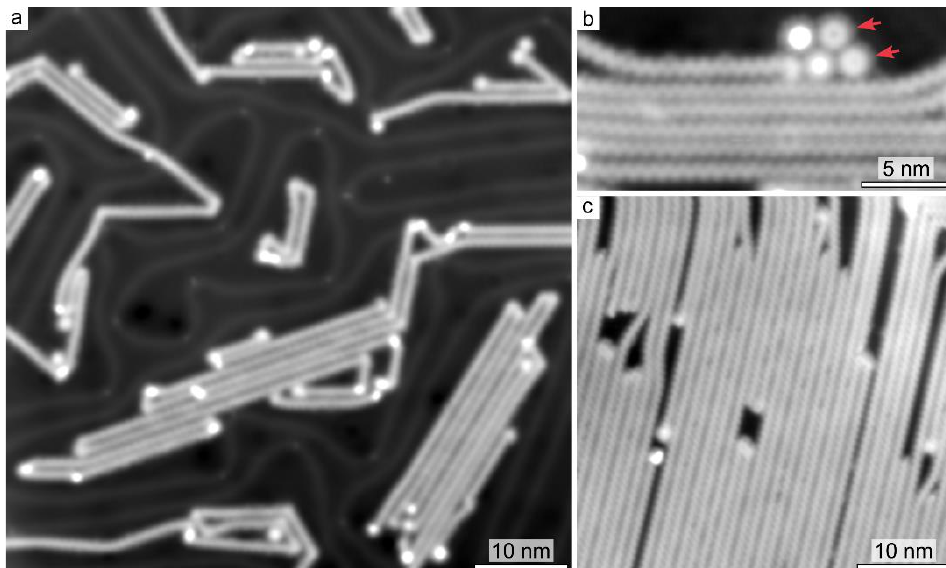
Figure 1. Constant-current STM images after annealing to 470 K of a Au(111) surface covered by a submonolayer ( a , b ) and multilayer ( c ) of DBTP. ( b ) Arrows highlight macrocycles. Measurement parameters: ( a ) tunneling current I = 1.9 pA, sample bias voltage V = 1.0 V; ( b ) I = 5 pA, V =1.0 V; ( c ) I = 2.6 pA, V = 1.0 V.